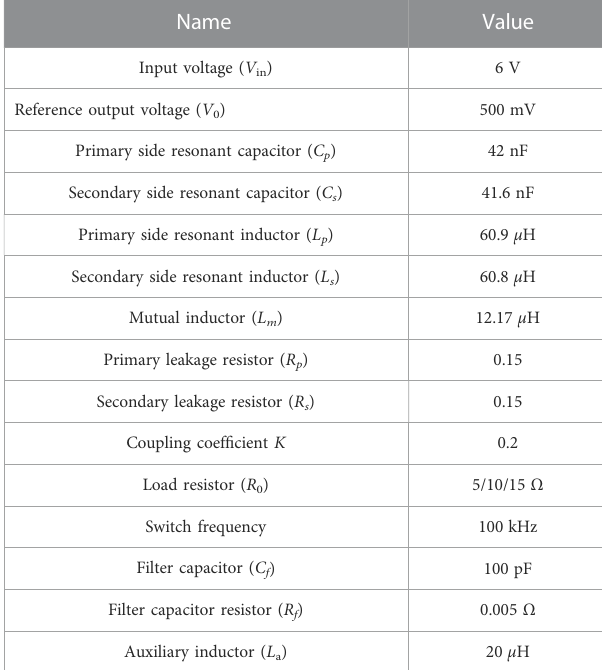
TABLE 4 Ratings in experimental